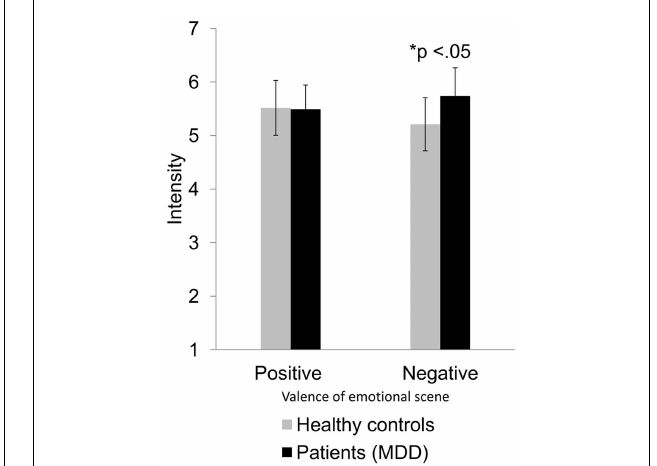
FIGURE 3 | Differences in rating intensity of patients with MDD and healthy controls for positive and negative emotional interactions . Average intensity ratings and their standard deviations are displayed as a function of participant group (healthy controls vs. patients with MDD) and valence of depicted emotional scene (positive vs. negative).The difference is significant at the 0.05